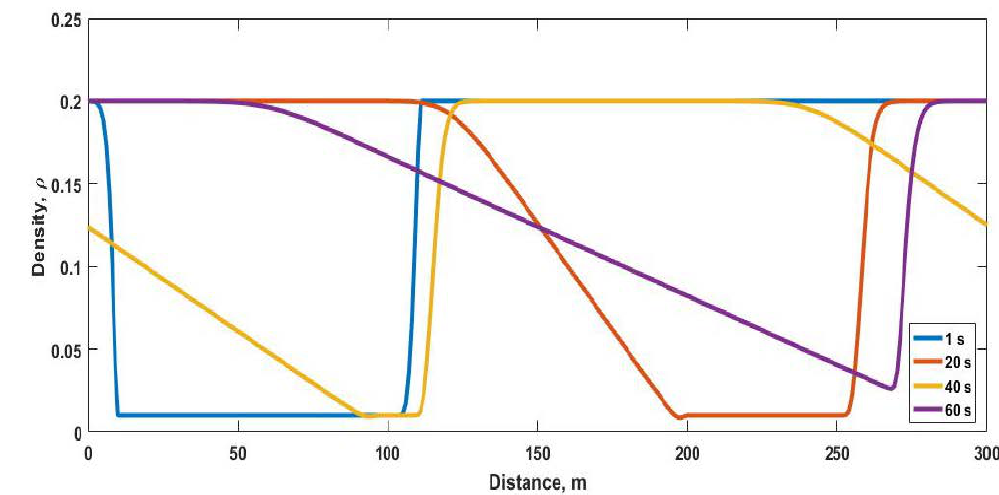
Figure 1. Normalized traffic density with the proposed model on a 300 m circular road with h = 20 m at 1 s, 20 s, 40 s and 60 s.